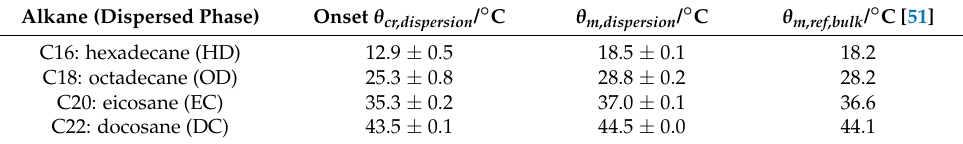
Table A2. Onset crystallization temperature onset ϑ cr , dispersion , melting point/ temperature ϑ m , dispersion of the alkane dispersions and reference melting temperature of the bulk ϑ m , ref , bulk according to [51]. Alkane (Dispersed Phase) Onset θ cr,dispersion / ◦ C